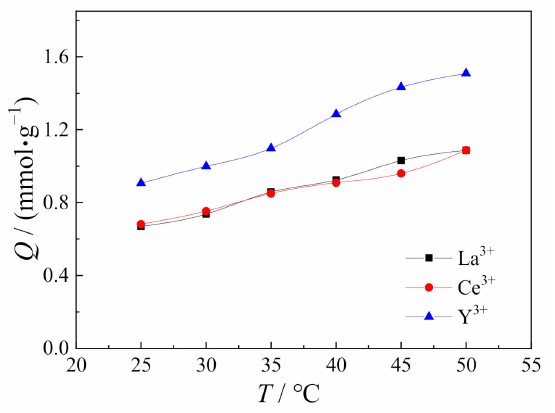
Figure 10. Effect of temperature on the adsorption capacity of PAMHA. ( C 0 = 0.01 mol · L − 1 , 5 h, pH values for La 3+ , Ce 3+ , and Y 3+ were 1.5, 3.0, and 2.0, respectively.)